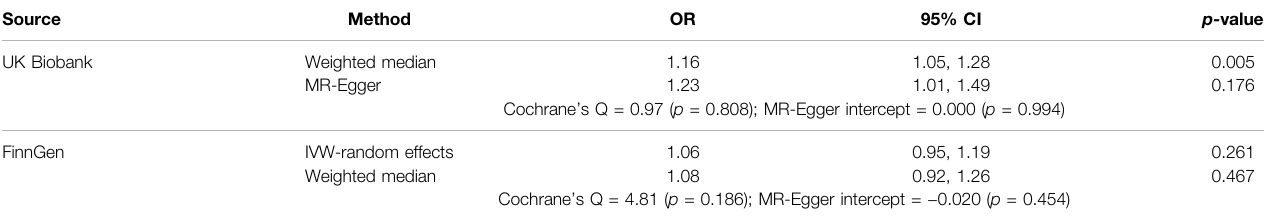
TABLE 2 | Association of genetically predicted growth differentiation factor 15 levels with gallstone disease risk in Mendelian randomization sensitivity analysis.